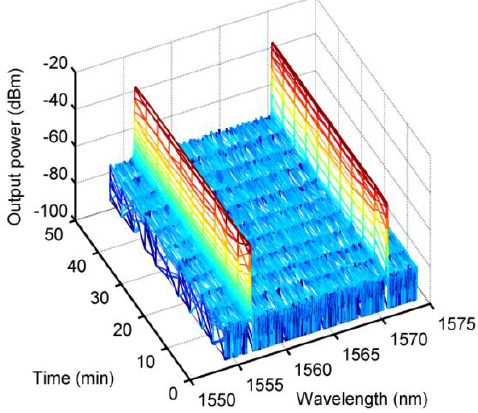
Figure 11. The stability test results of the laser.